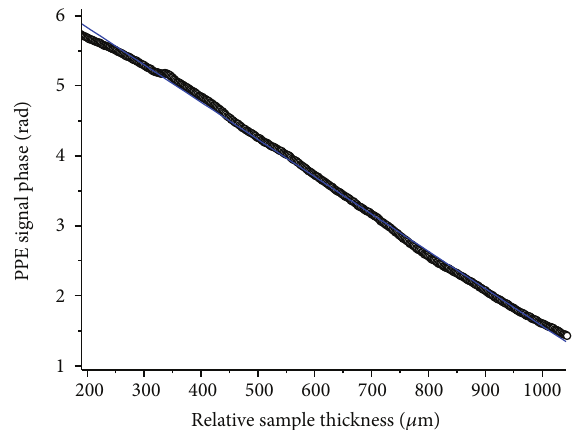
Figure 5: PPE signal phase as a function of the cavity length, having water as a sample and PLZT ceramic as PE detector; the solid line represents the best fitting of (2) to the experimental